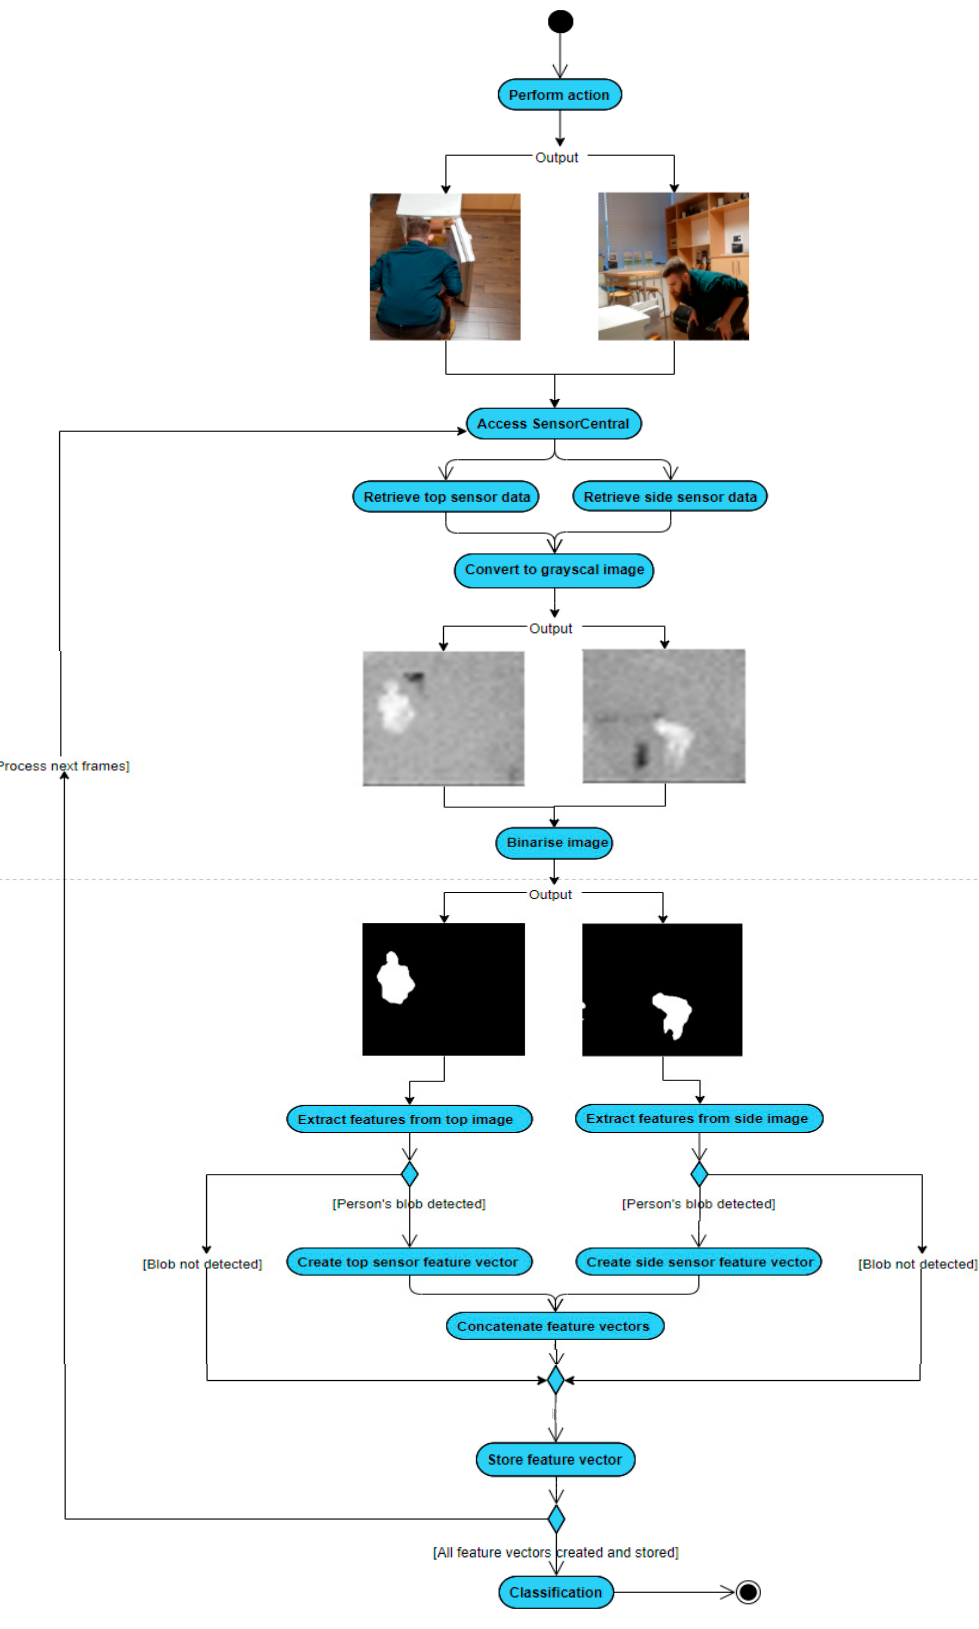
Figure 1. Overview of the initial stages of the method.